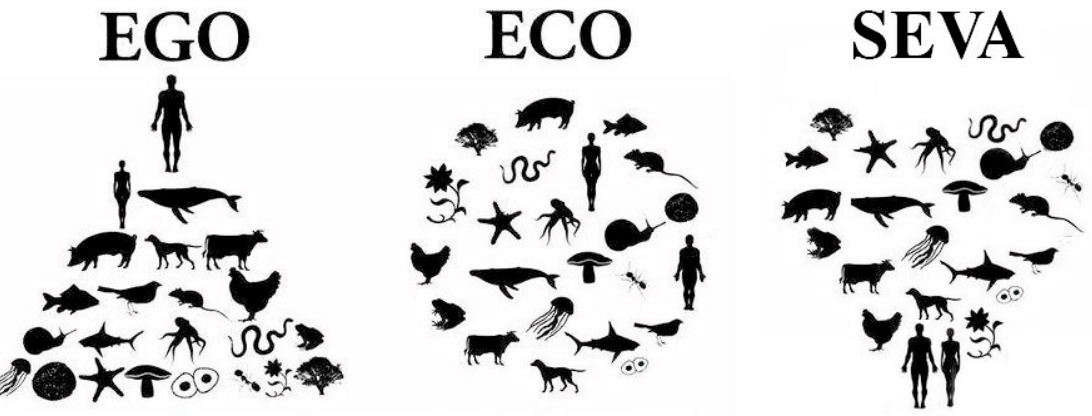
Figure 3. The representation of the egocentric, ecocentric and service-minded social groups (Source: adapted from [61] using Freepik).